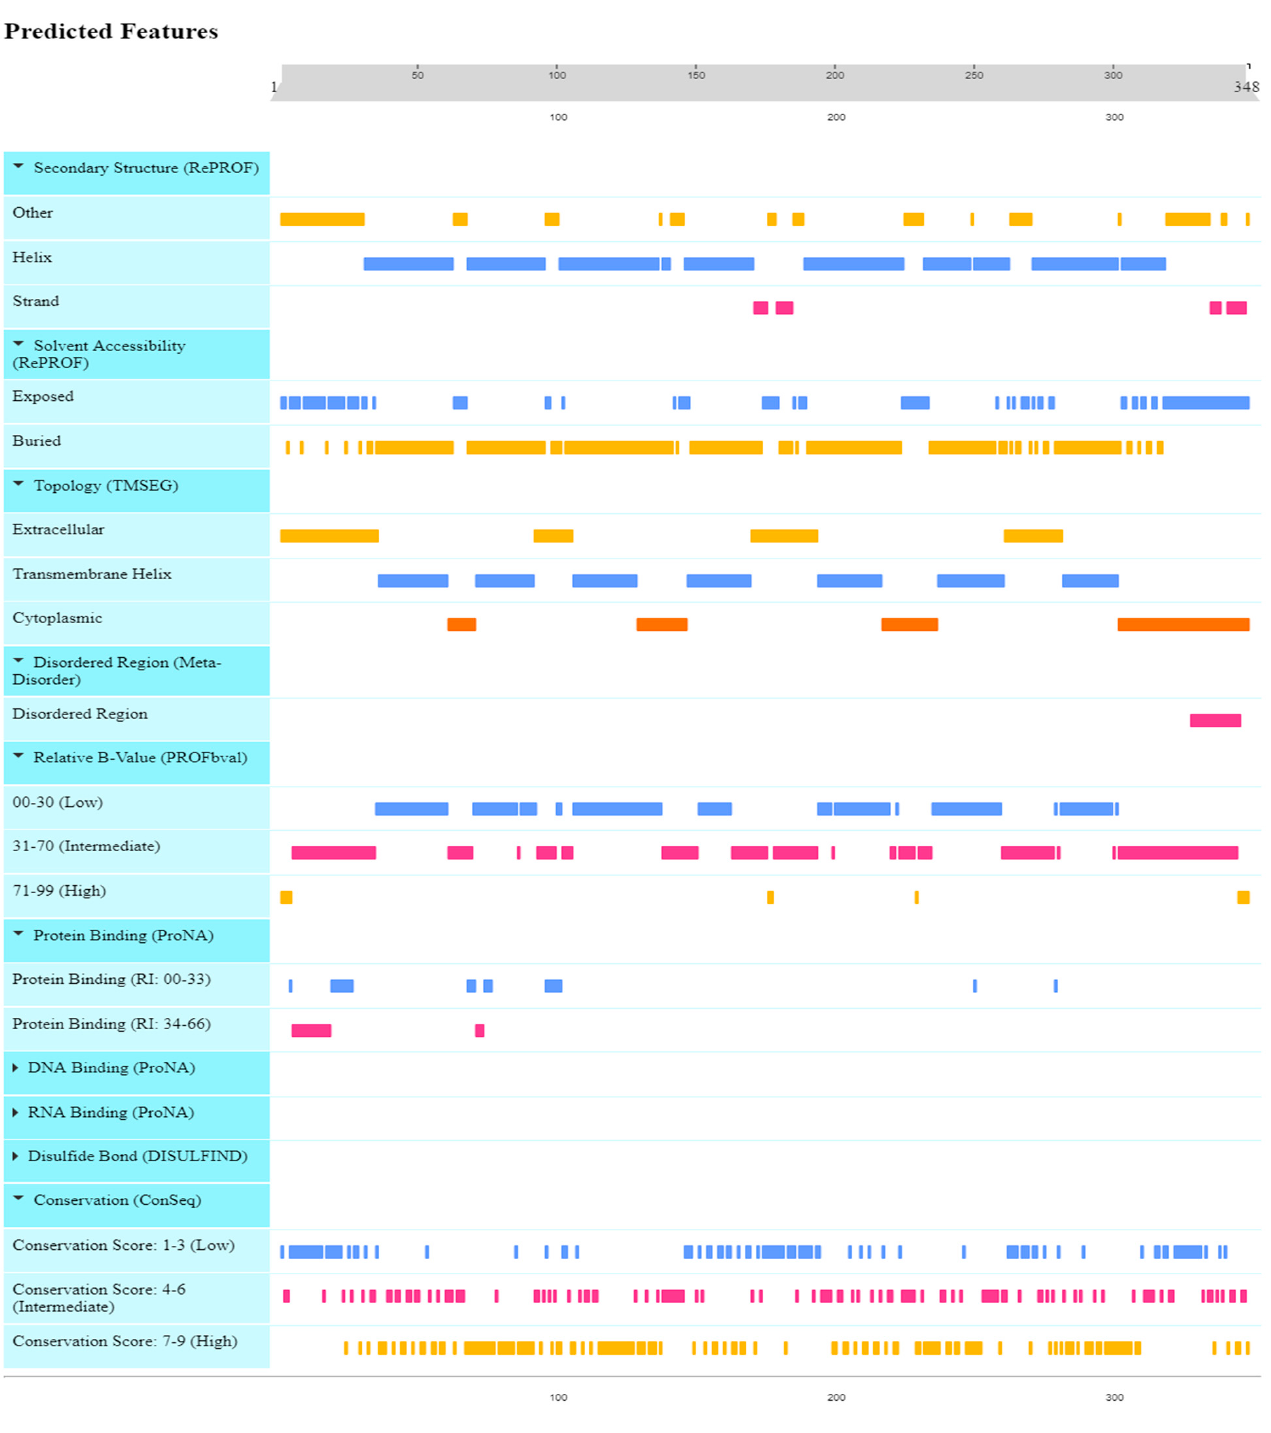
Figure 6. Structural features of the CXCR4 protein (motifs, interaction sites, DNA, RNA binding, topology, and conservation) were predicted using the Rost Lab’s Reprof secondary structure pre- dictor and accessibility predictor. An alignment of human CXCR4 sequences was used to make the